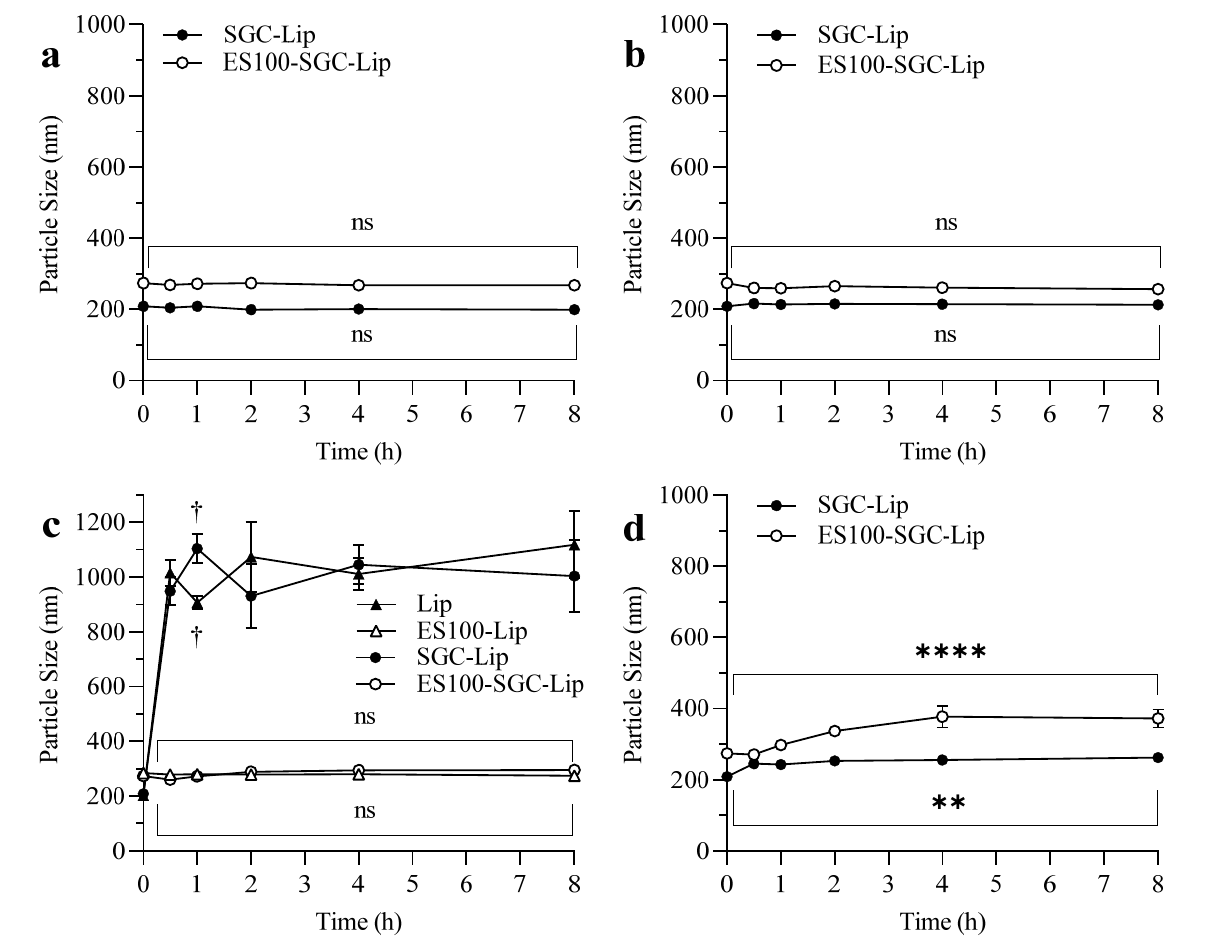
Figure 6. Particle size changes of different liposomal formulations: SGC-Lip and ES100-SGC-Lip in ( a ) SGF (pH = 1.2), ( b ) FaSSIF (pH = 6.5), ( c ) FeSSIF (pH = 5), and ( d ) PBS (pH = 7.4). Notes: In Figure ( c ), two additional formulations, Lip and ES100-Lip, were also tested in FeSSIF. Tukey test was conducted to compare the particle size of the liposomal formulations before and after incubation for 8 h in the release media. n = 3. (ns p ≥ 0.05, ** p < 0.005, **** p < 0.0001). †: Results do not meet DLS criteria due to liposomal destruction by bile salt.